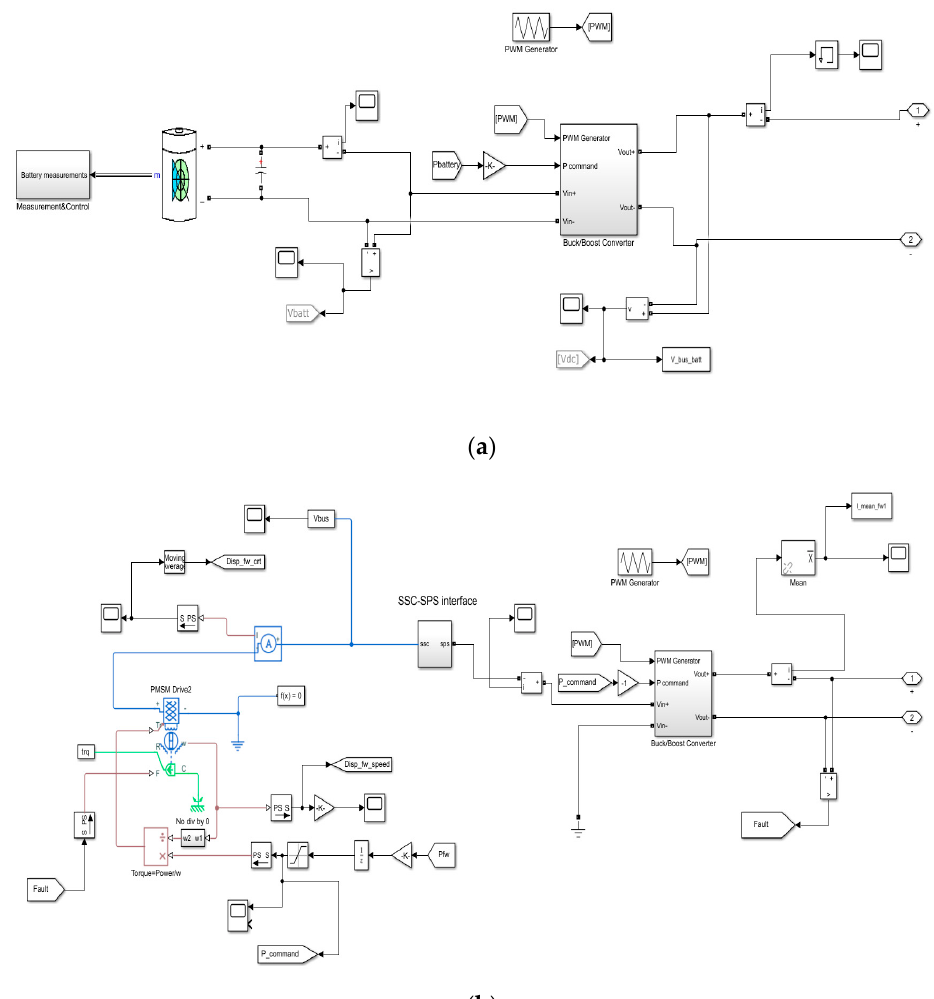
Figure 4. Detailed section of the battery ( a ) and flywheel ( b ) sections, with their buck/boost converters.